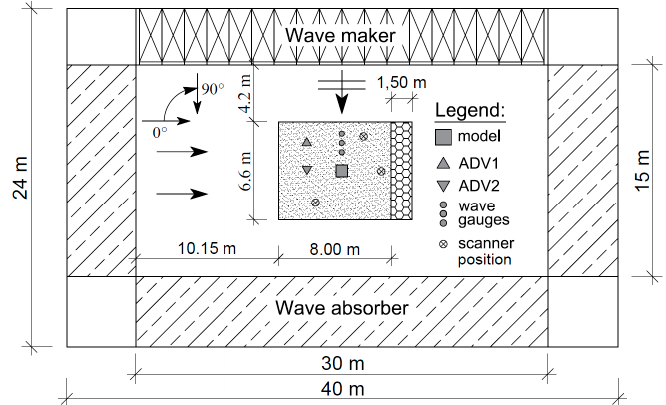
Figure 1. Sketch of the wave basin, plan view including the test setup, unidirectional current is coming from left to right with 0°, waves are propagating perpendicular in 90°.